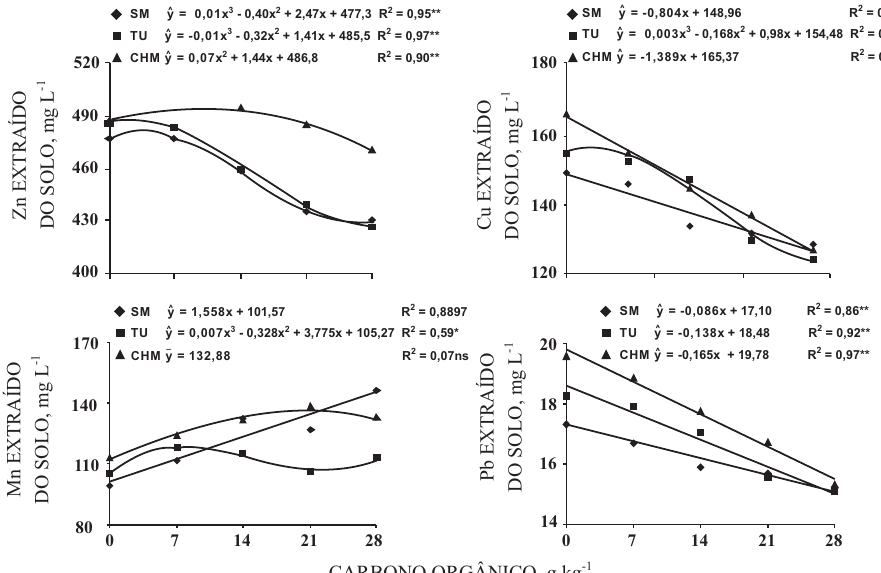
Figura 1. Teores de zinco, cobre, manganês e chumbo extraídos por DTPA em função de doses de carbono orgânico aplicadas ao solo via solomax (SM), turfa (TU) e concentrado húmico mineral (CHM). (ns) não- significativo. (**) e (*) significativos a 1 e 5 %,